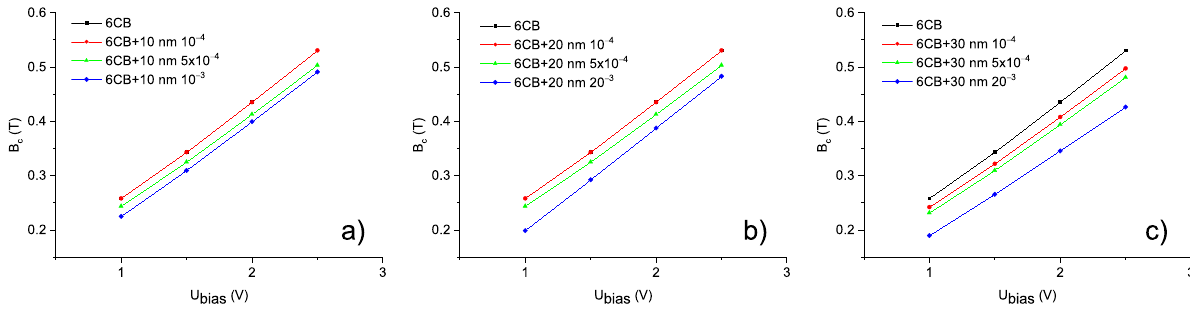
Figure 9. Calculated dependencies of threshold magnetic field B c on bias voltage U bias for pure 6CB and composites containing ( a ) 10 nm, ( b ) 20 nm ( c ) and 30 nm